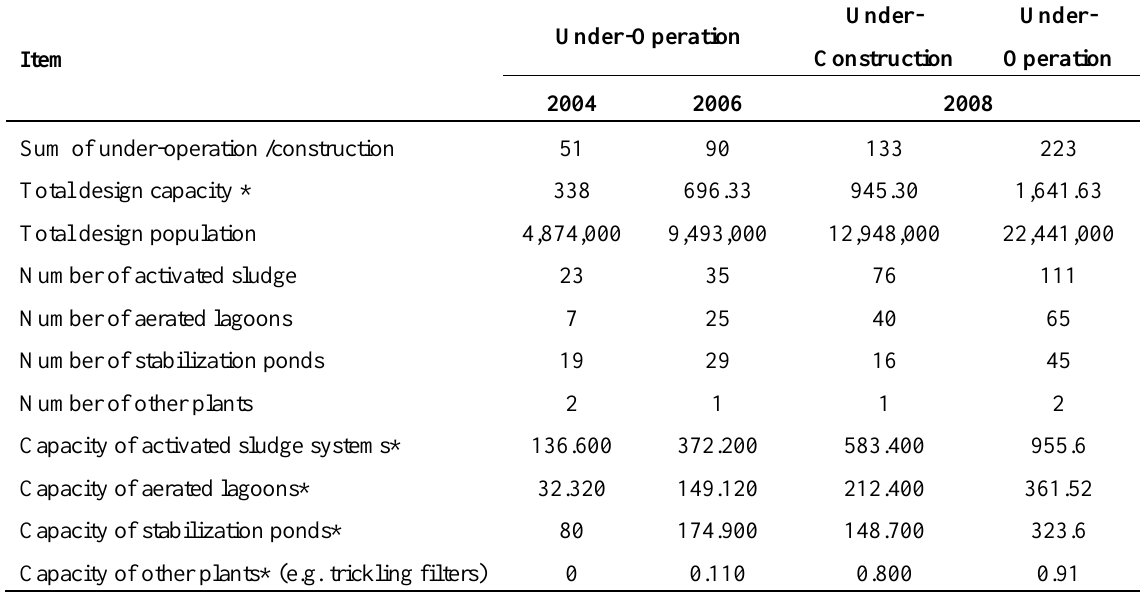
Table 1. Under-construction and under-operation WWTPs in Iran (NWWC, 2006, 2008b).